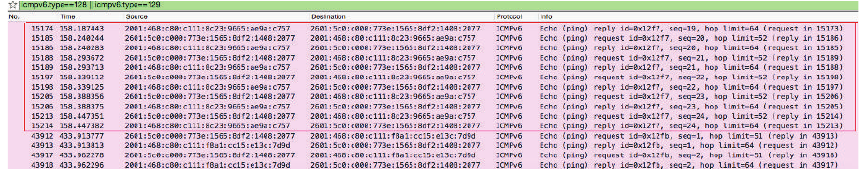
Figure 6: Wireshark capture showing packets hitting CN before the IP address